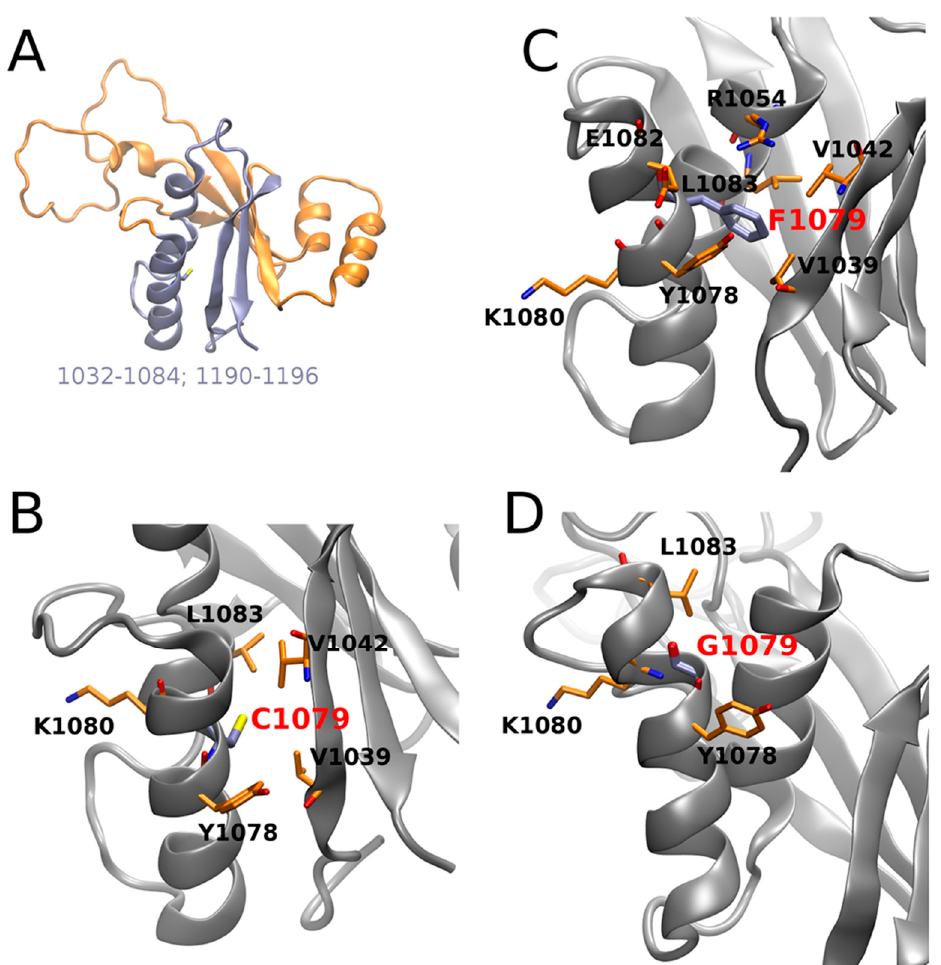
Figure 4. ATP7B N-domain (1032-1196, PDB ID: 2ARF, NMR the first model): ( A ) interface (in cyan) of C1079; ( B – D ) residue in position 1079 and its representative interaction residue counterparts in wild type, C1079F and C1079G, respectively. Protein backbones are shown as gray shapes, and particular residues as orange sticks.